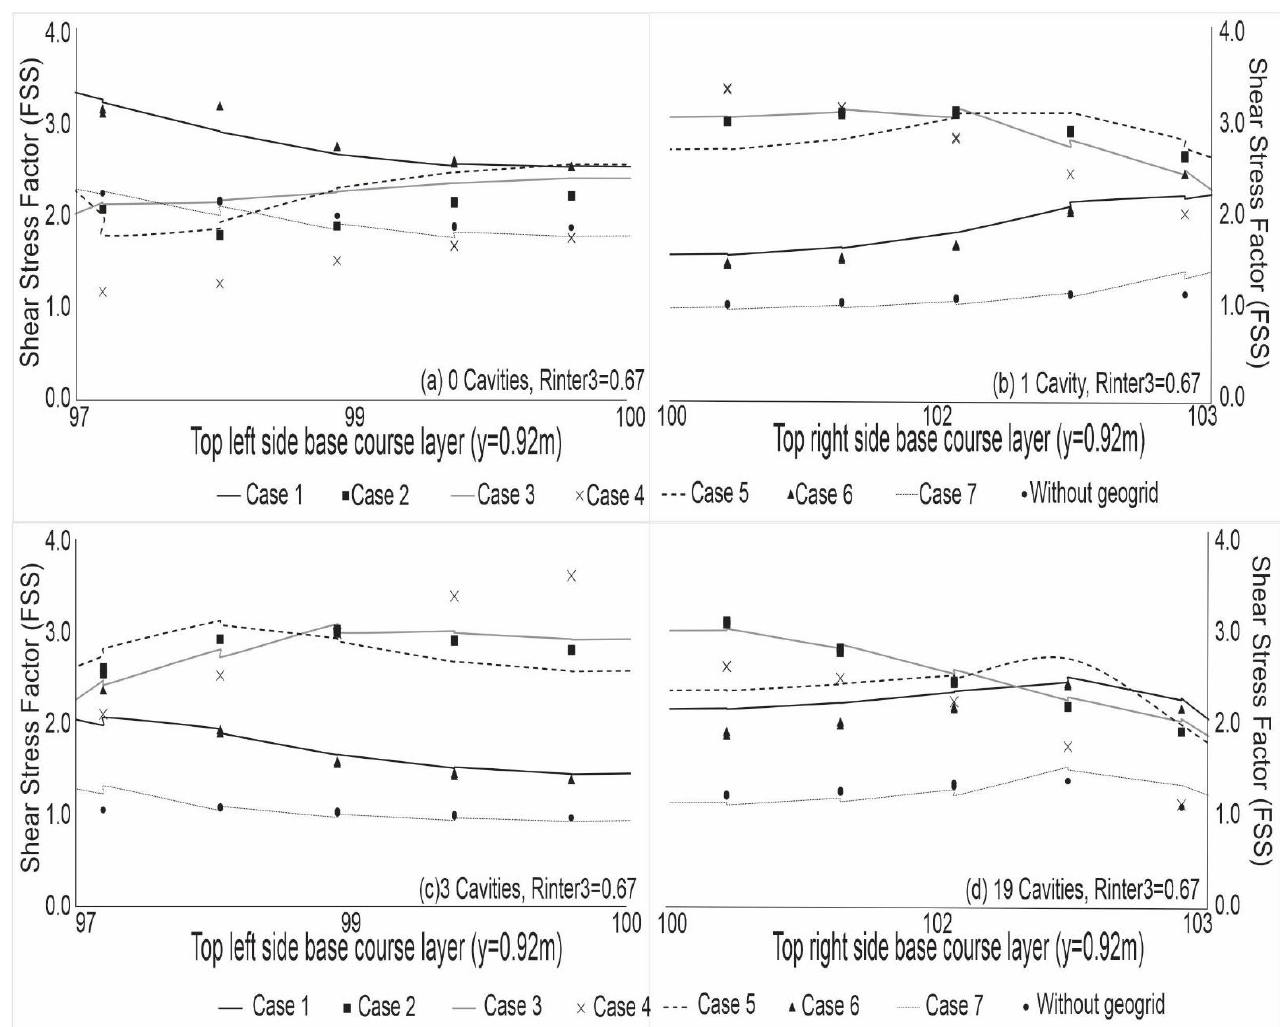
Figure 10. Graph groups of Mobilized FSS along of the base course layer, considering the seven Cases, a R inter3 = 0.67, truck load and ( a ) 0 cavities, ( b ) 1 cavities, ( c ) 3 cavities and ( d ) 19 cavities in the soil.